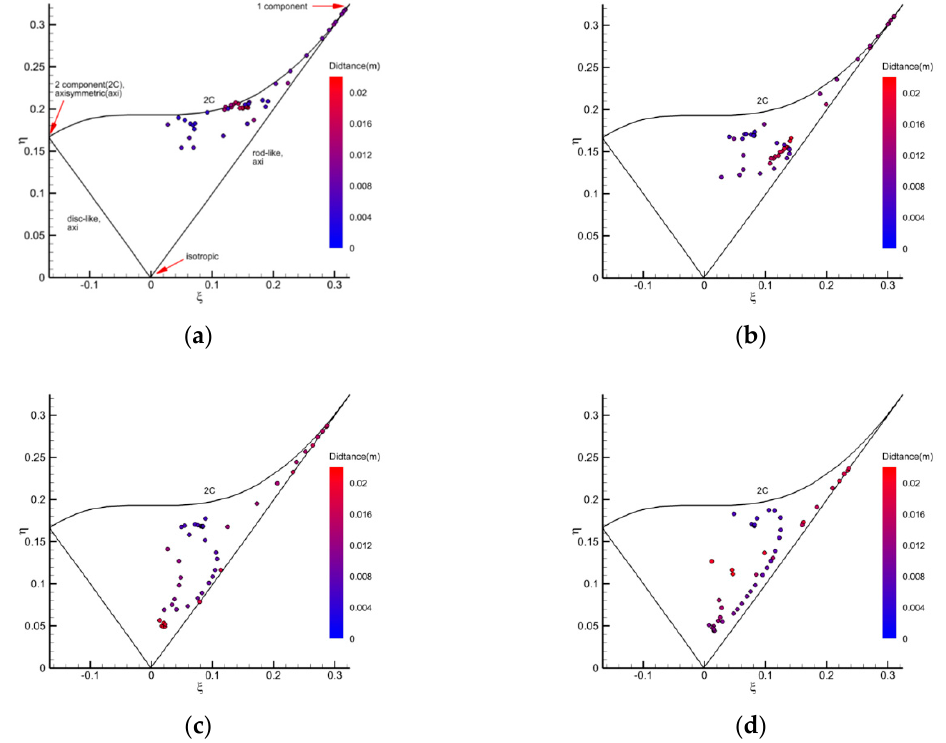
Figure 17. Distribution of points from the extracted lines in the Lumley triangle at 30% span: ( a ) No.1;